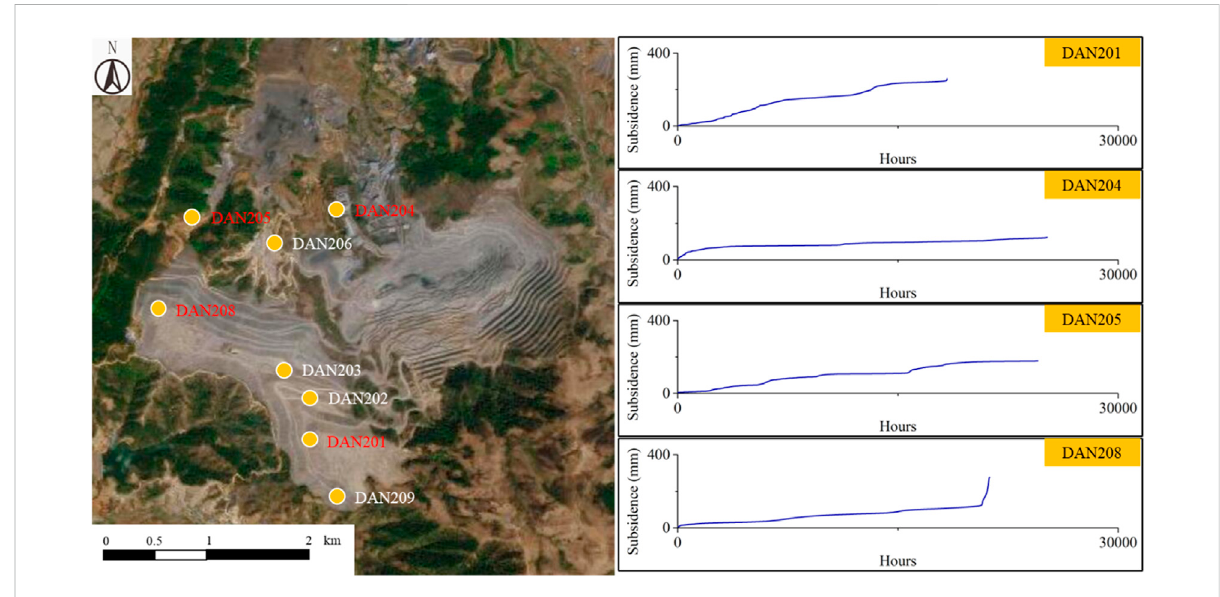
FIGURE 1 Con fi guration of GNSS monitoring points in the case study